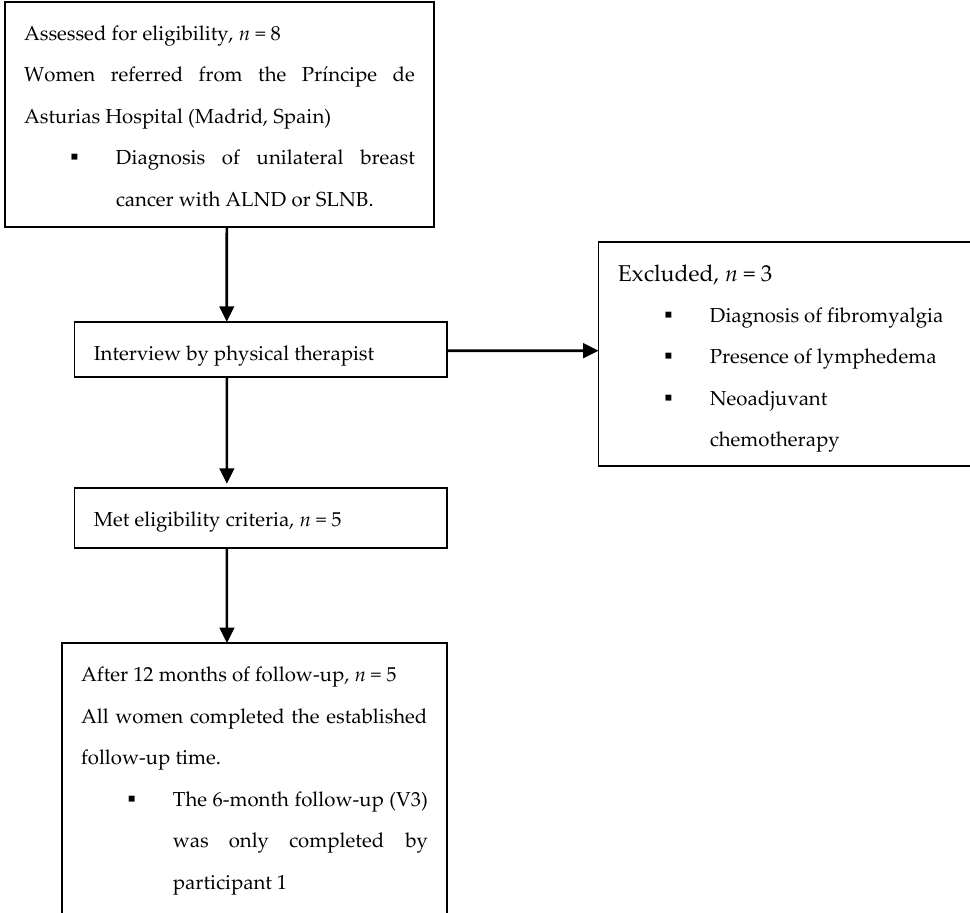
Figure 1. Participant flow diagram. ALND, axillary lymph node dissection; SLNB, sentinel lymph node biopsy. Table 1. Characteristics of the